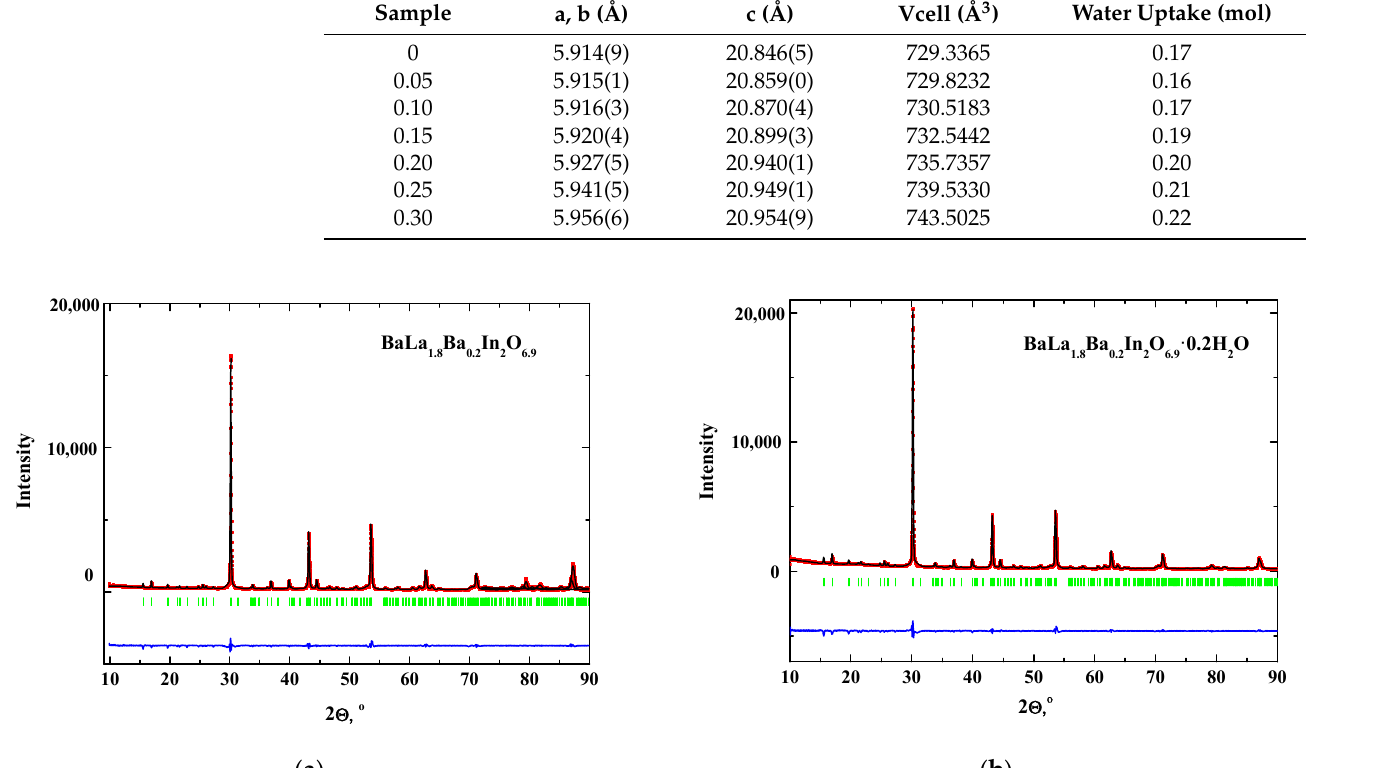
Figure 2. and hydrated Figure 2. The XRD data for the anhydrous BaLa 1.8 Ba 0.2 In 2 O 6.9 ( a ) and hydrated